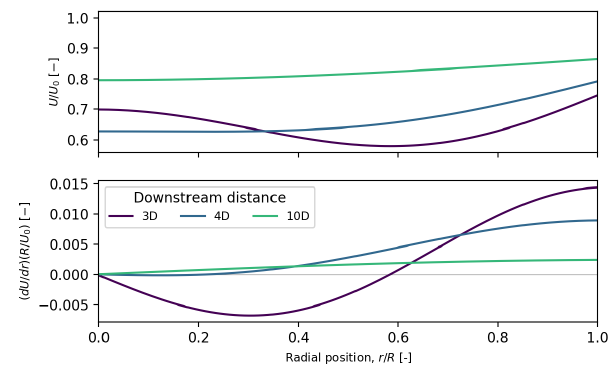
Figure 2. Radial functions of wind speed deficit and its derivative for varying turbine spacing distances (generated using DWM, D = 96 .